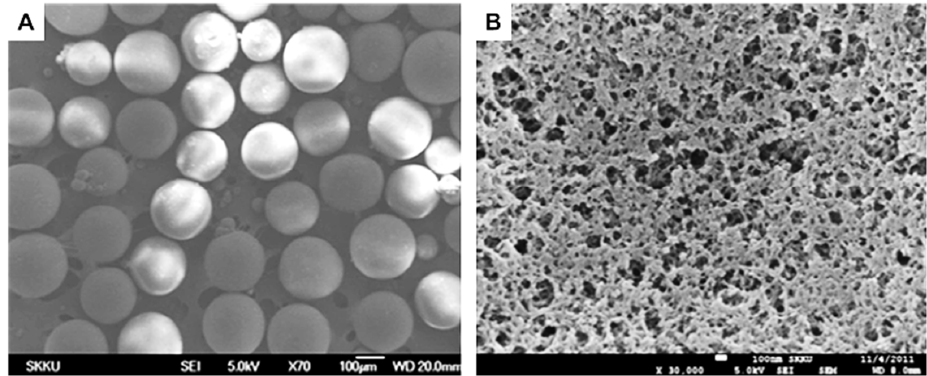
Figure 9. SEM micrographs of ( A ) exterior and ( B ) interior of Zn(II) ‐ IP particles composed of 2,2 ′‐ bipyridyl and 4 ‐ VP monomers cross ‐ linked with EGDMA (reproduced with permission from Ref. [90]. Copyright 2013 Elsevier).